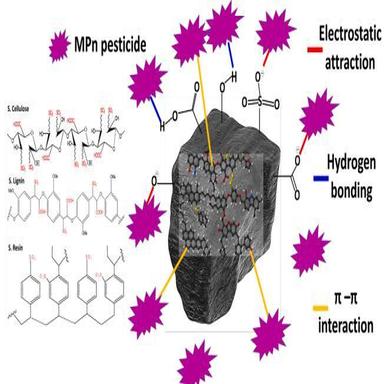
Schematic diagram for the adsorption mechanism of MPn molecules by the sulfonated coal samples.